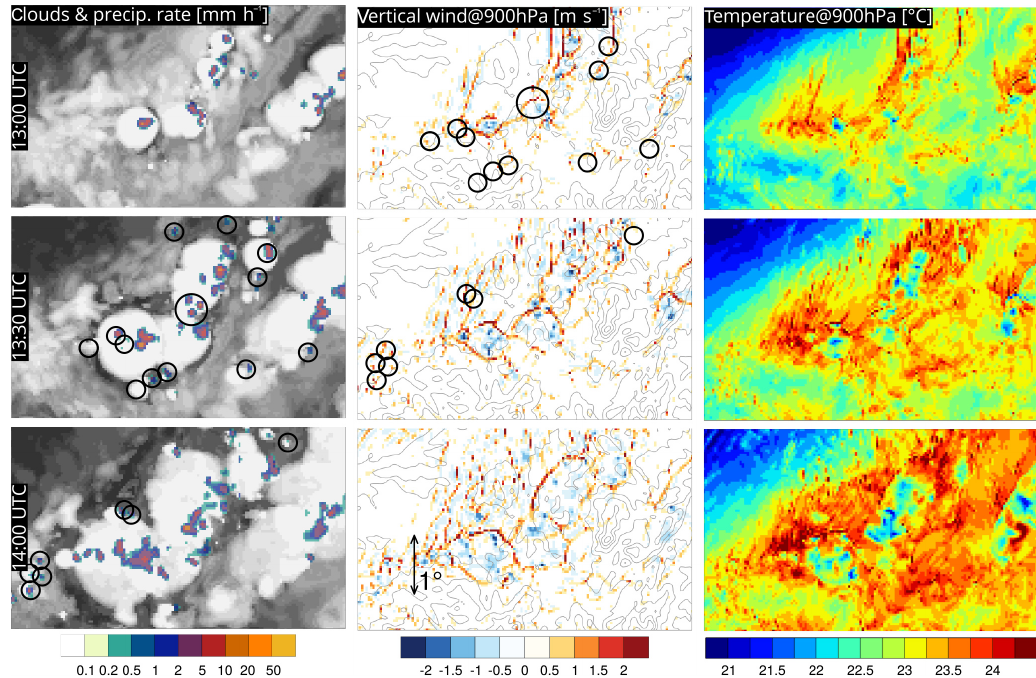
Figure 10. Three consecutive snapshots showing (left) precipitation rate [mmh − 1 ] and clouds, (middle) vertical wind at 900hPa [ms − 1 ] and terrain contours [100m contour], (right) temperature at 900hPa [ ◦ C]. The domain corresponds to the red rectangle in Fig. 9. The black circles in the vertical wind figures denote locations of new convective cells in the next snapshot. In the succeeding snapshot the same convective cells are marked in the left column.